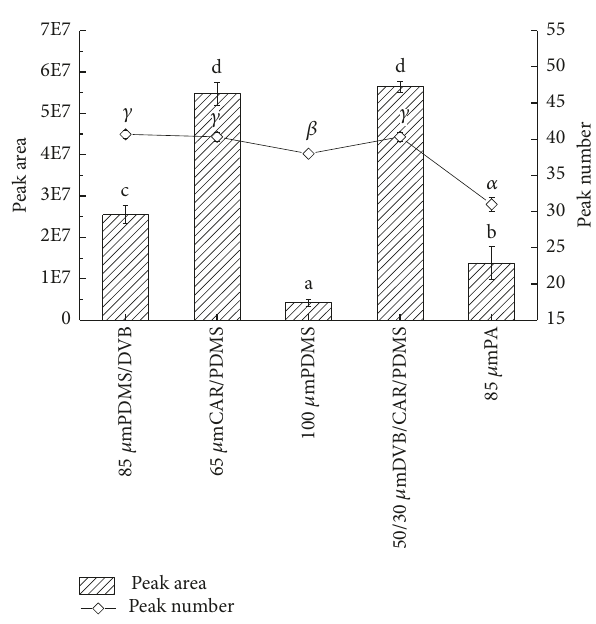
Figure 1: Effects of different fibers on extracting volatiles of pepper chicken soup. English letters “a”, “b”, “c”, “d” indicate Duncan’s multiple range test among peak areas of the five fibers. Greek letters “ 𝛼 ”, “ 𝛽 ”, “ 𝛾 ” indicate Duncan’s multiple range test among peak numbers of the five fibers. Data in the same group marked with different letters mean significant difference ( p < 0.05) and the same letters denote not significant difference ( p <